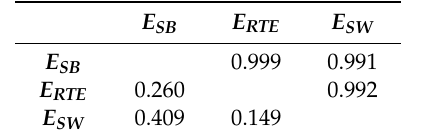
Table 5. Comparison of actual evapotranspiration (ETa) estimated over the area presented in Figures 10 and 11 with SB, RTE, and SW methods based on 3 July 2019 Landsat scene. Correlation coefficient is presented above the diagonal and mean differences below it (mm/d, column minus row entries).